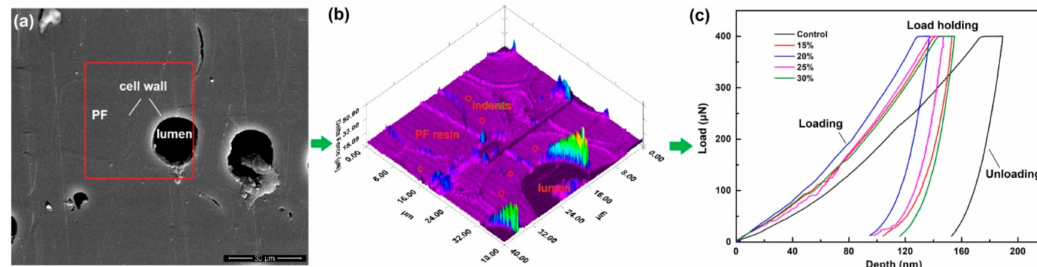
Figure 2. Wood sample preparation for nanoindentation test: ( a ) Microscope images showing the test location; ( b ) Scanning probe microscopy (SPM) image showing the positioning of indents; ( c ) Typical